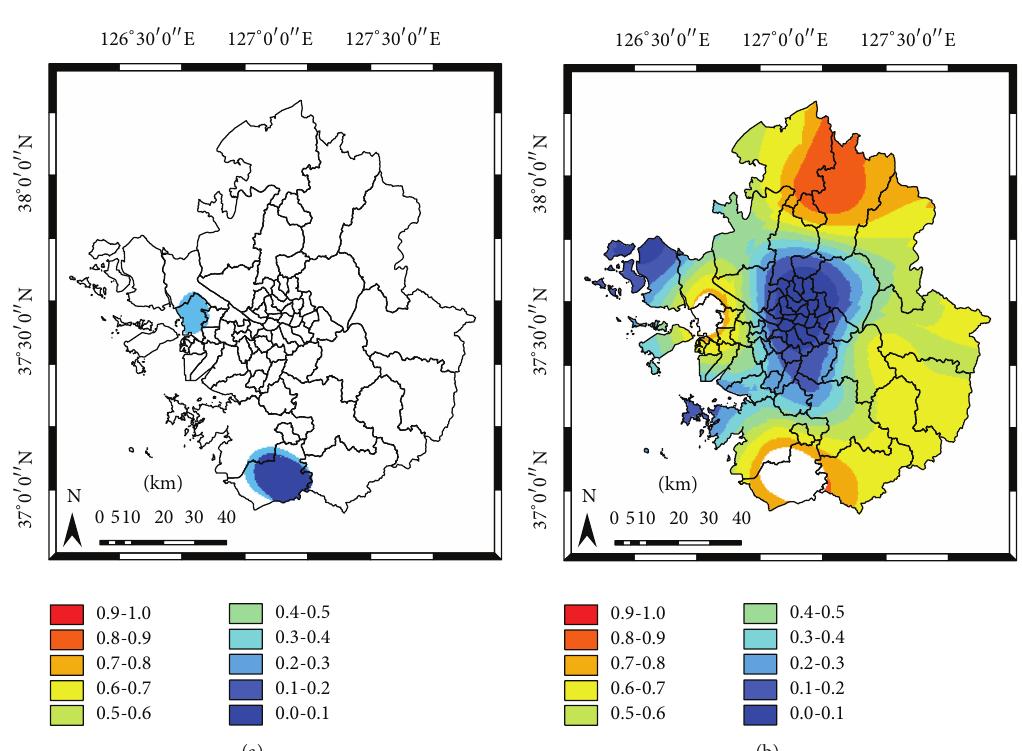
Figure 8: Risk associated with the classification of areas where the PM 10 concentration exceeds 80 𝜇 g/m 3 in April 2009: (a) risk 𝛼 and (b) risk 𝛽